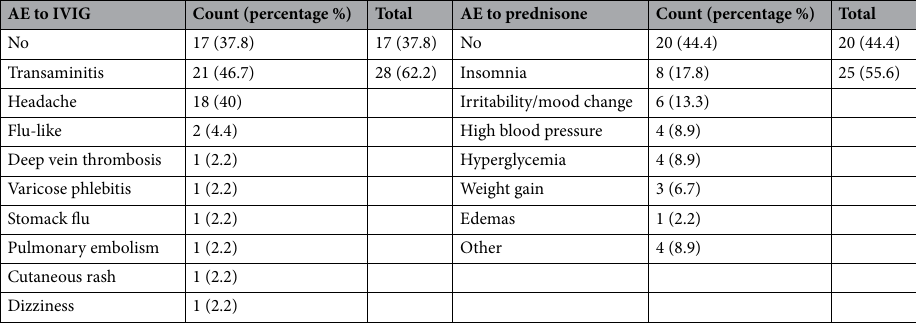
Our series Bae et